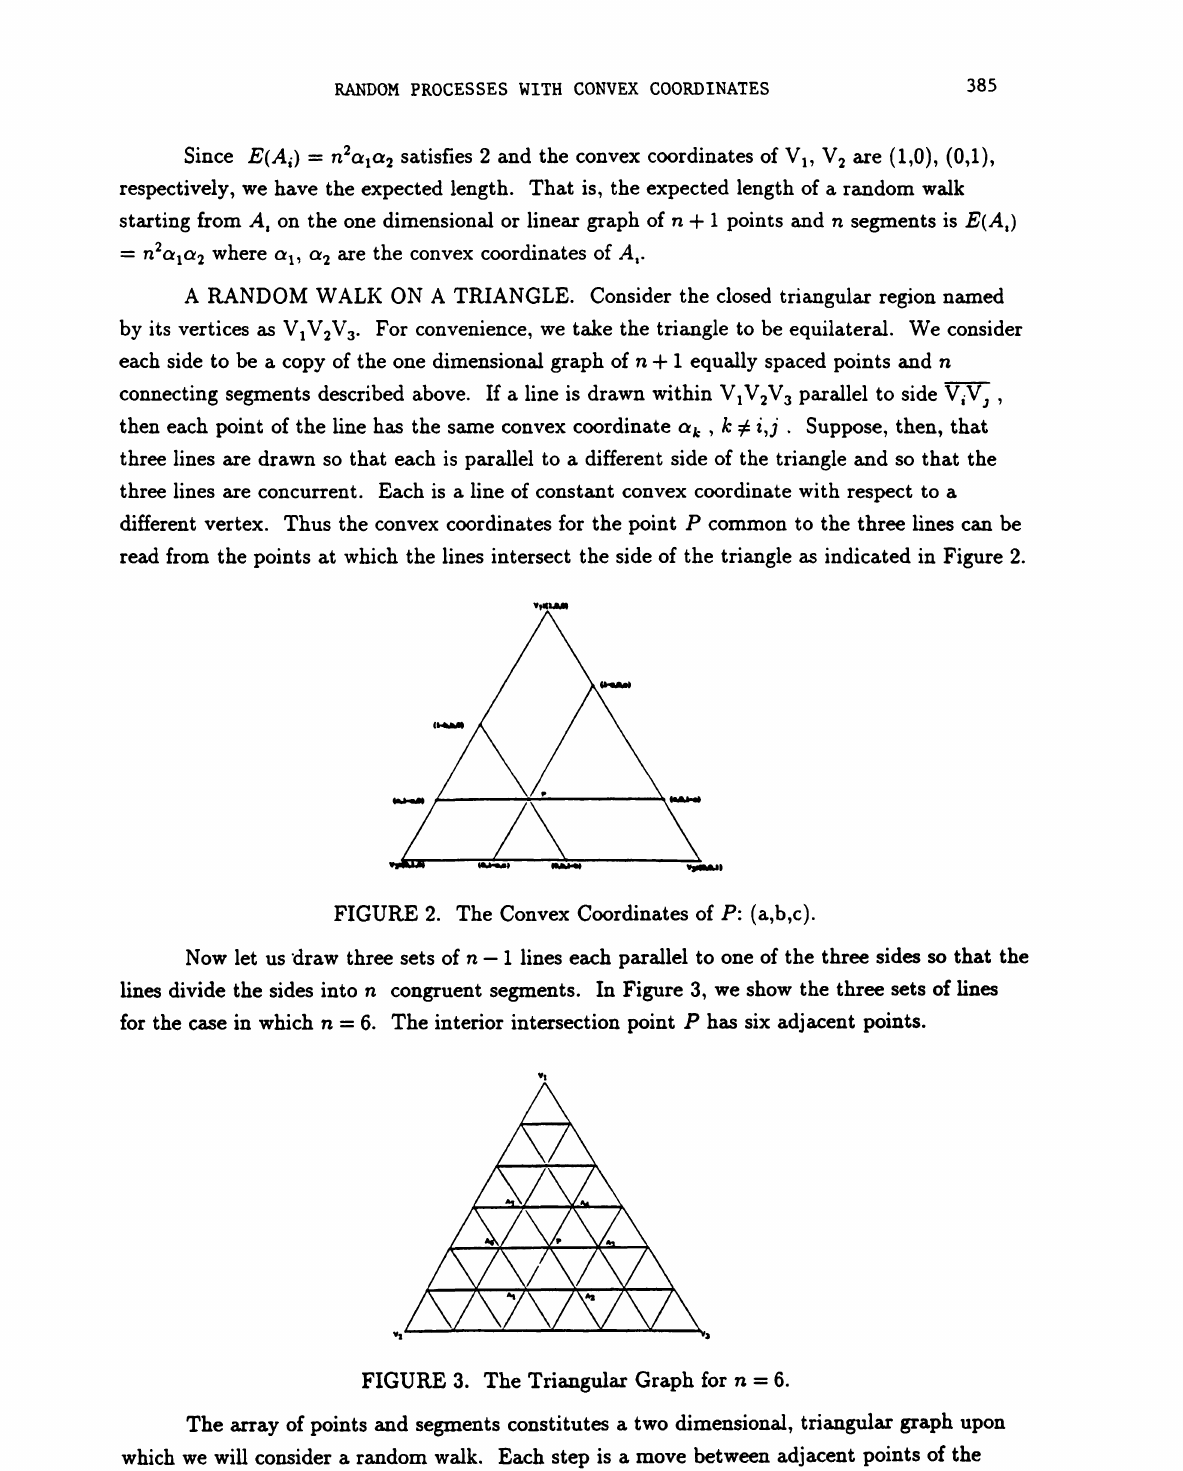
FIGURE 3. The Triangular Graph for n